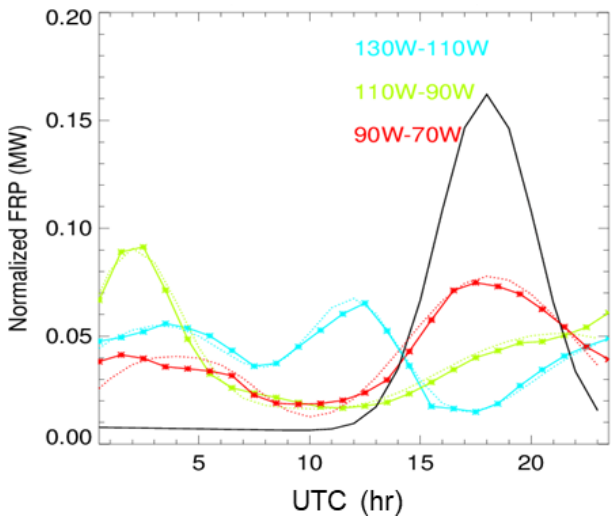
Figure 2. The diurnal cycle functions (solid lines (green, blue, and red)) developed based on GOES-16 FRP data during the FIREX- AQ period. The original WRF-Chem diurnal cycle function is also shown (solid black line). The dashed lines (green, blue, and red) show the normalized